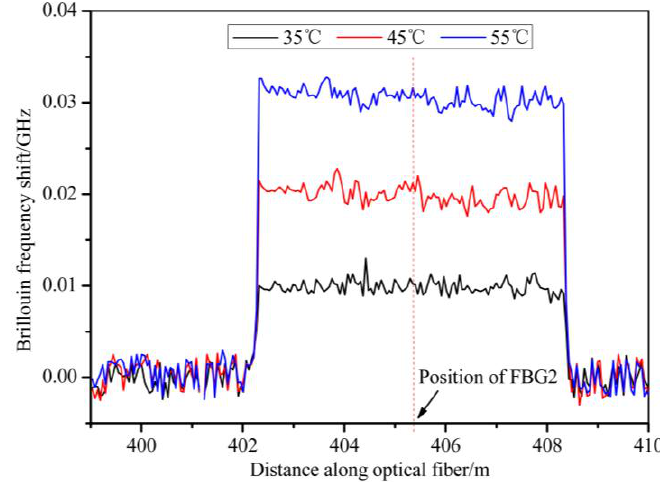
Figure 7. The Brillouin frequency shift (BFS) of the optical fiber with different temperatures.